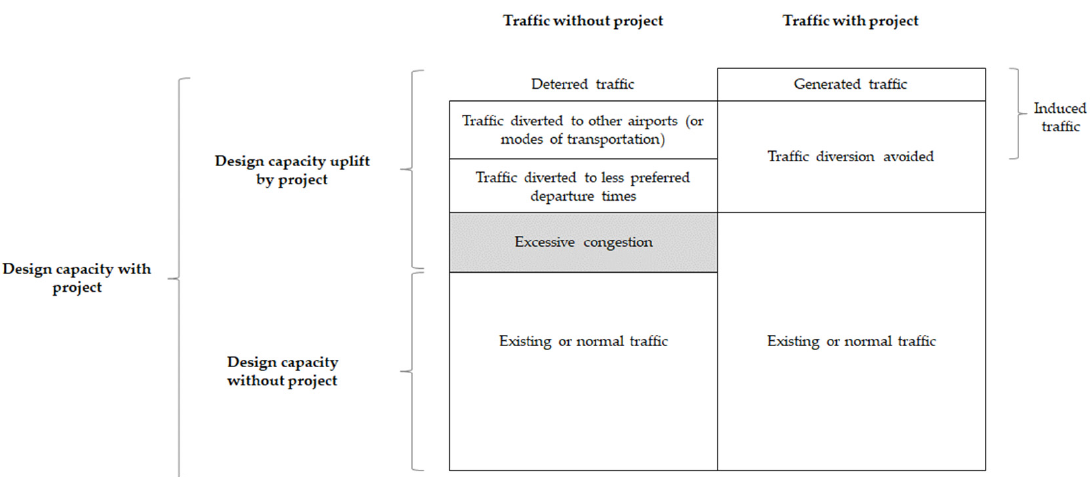
Figure 6. Traffic types with and without project for an airport capacity expansion project.